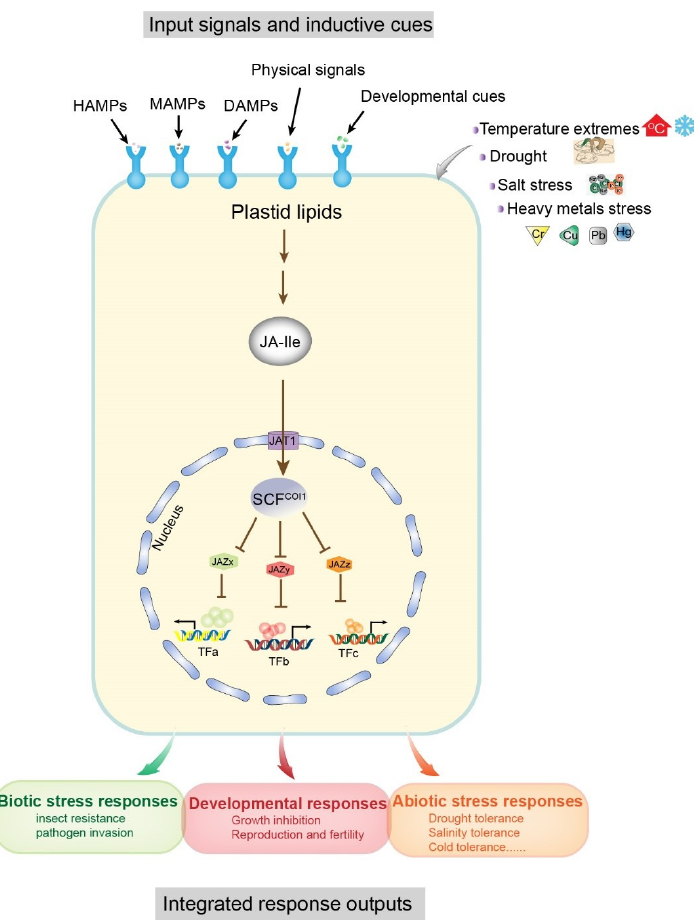
Figure 1. Input signals and output responses of the core jasmonoyl-L-isoleucine (JA-Ile) signaling pathway. Associations of the modular design of JA-Ile signaling with a variety of inductive cues (top) and physiological output responses (bottom) are shown as a schematic diagram. Inductive signals include biotic stresses (microbe and herbivore) and damage related to molecular patterns (MAMPs, microbe-associated; HAMPs, herbivore-associated; and DAMPs, damage-associated) arising from damaged plant cells, attacking organisms, and abiotic stresses. Pattern recognition re- ceptors on the cell surface recognize the signals and resynthesize JA-Ile from plastid lipids. The degradation of multiple JAZ proteins (exemplified by JAZx-z) is promoted by the activation of the E3 ubiquitin ligase SCF COI1 and the 26S proteasome. Subsequently, JAZ-interacting transcription fac- tors (exemplified by TFa–c), which govern diverse physiological output responses involved in growth, development, and tolerance to biotic and abiotic stresses, are upregulated due to the deg- radation of JAZ. The conserved core pathway may be repurposed to connect other input signals and transcription factors. Abbreviations: JA-Ile, jasmonoyl-L-isoleucine; MAMPs, microbe-associated molecular patterns; HAMPs, herbivore-associated molecular patterns; DAMPs, damage-associated molecular patterns; JAZ, jasmonate ZIM domain; SCF, [kinetochore protein 1 (SKP1)-CULLIN1 (CUL1)-F-box]; COI1, coronatine insensitive1; TF, transcription factor. Modified from [12]. In this review, we summarize recent progress in JA research, focusing on the biosyn- thesis and signal transduction of JAs, as well as their roles in biotic and abiotic stress re- sponses.